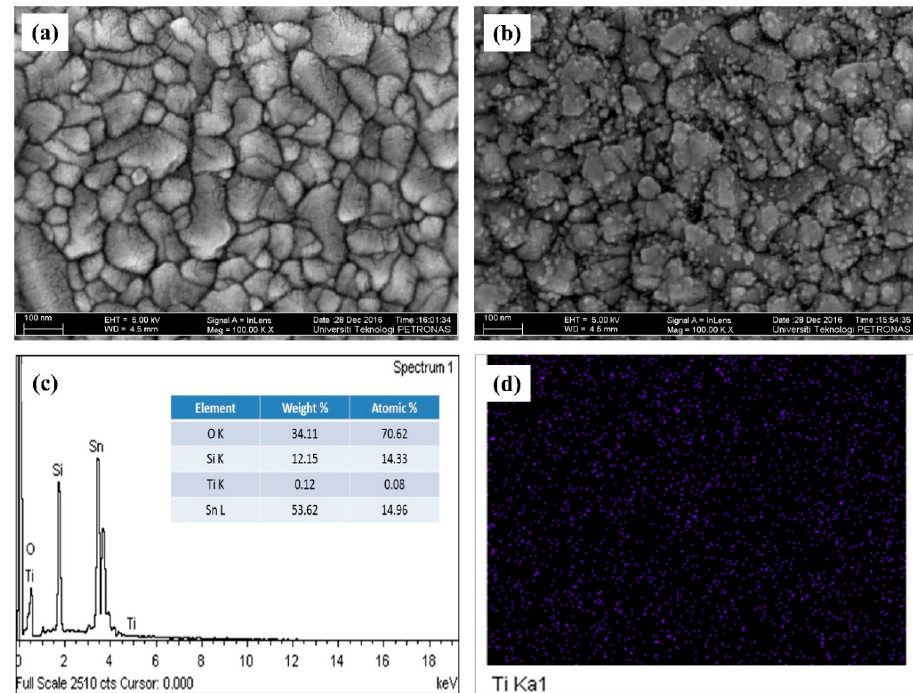
Figure 3. Field-emission (FE) SEM images of top view of fluorine-doped tin oxide (FTO) substrate ( a ) before and ( b ) after being coated with nanocrystalline TiO 2 ; ( c ) energy-dispersive X-ray spectroscopy (EDX) analysis and ( d ) element mapping of FTO substrate coated with nanocrystalline TiO 2 taken at 100,000× magnification.